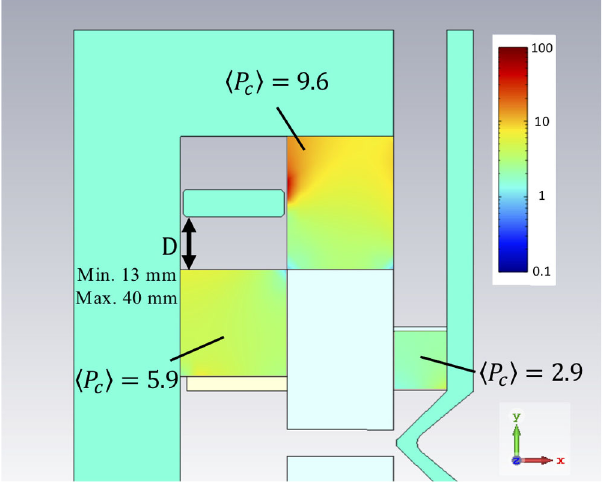
direction.FIG. 6. Permeance coefficient ( P c ) distribution in PMs for the shunt plate position (D) of 20 mm. h P c i s are the average value in